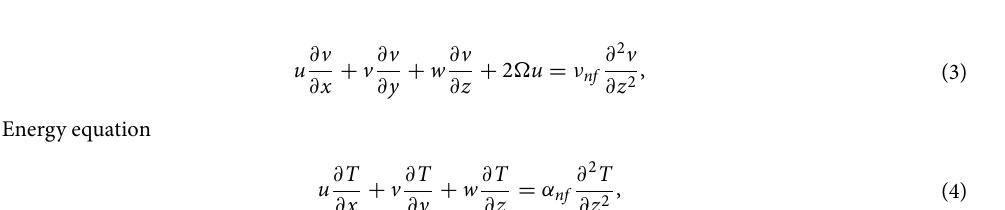
Figure 4. ( a ) Result of β over the velocity distribution f ′ (η) for CuO nanoparticle. ( b ) Result of β over the velocity distribution f ′ (η) for Ag